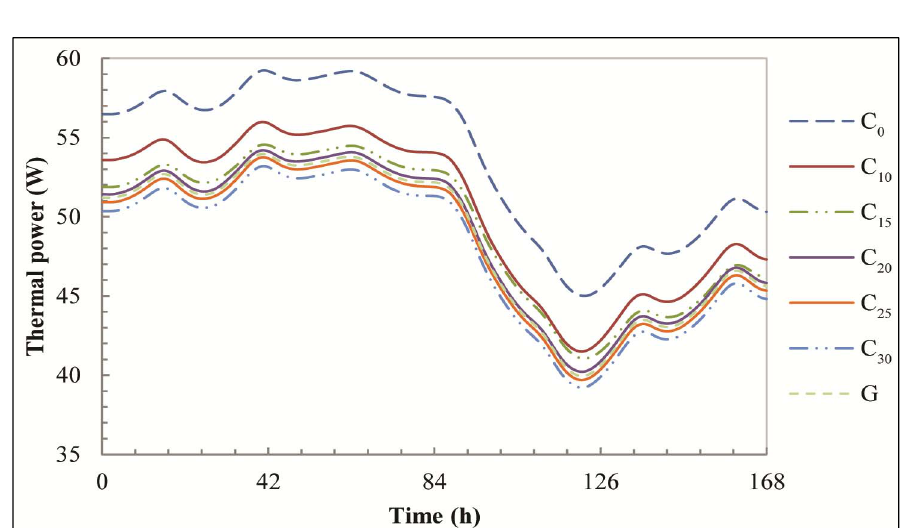
Figure 10. Thermal power transferred from the heated environment when the present concrete mixtures are